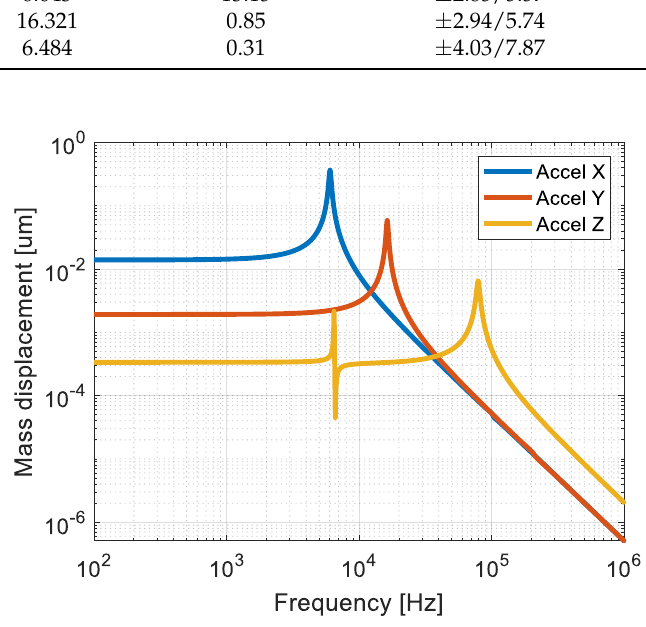
Figure 9. Frequency response of the accelerometer.